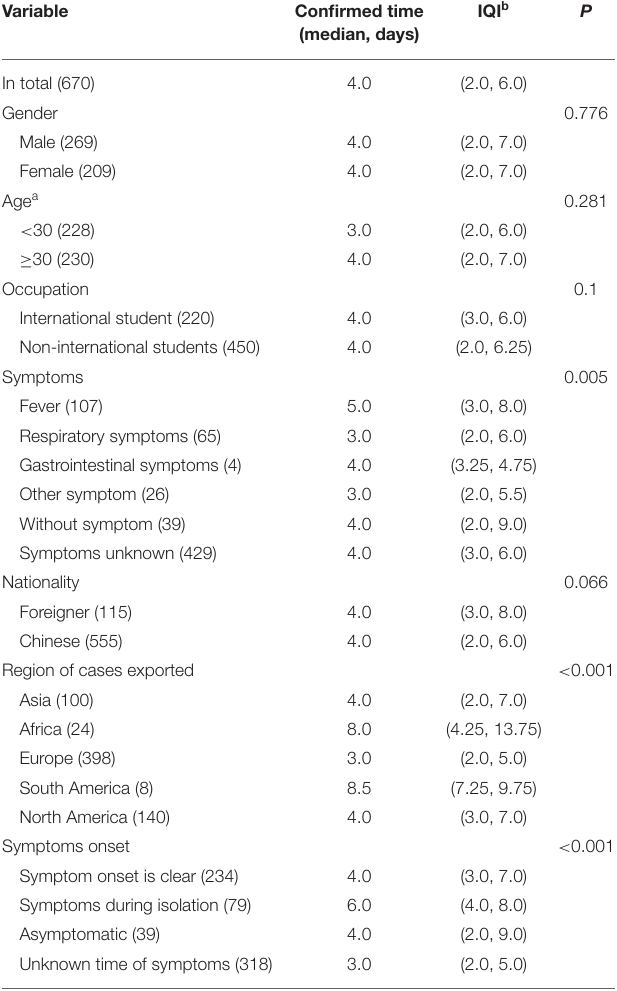
TABLE 4 | Confirmed time of imported COVID-19